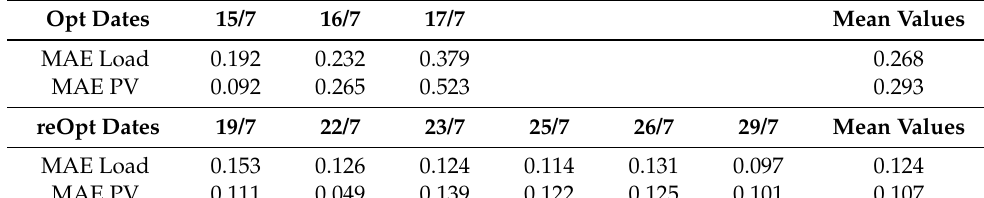
Table 2. MAE of load and PV forecasting tools (kW per hour quarter “kWh-q”).